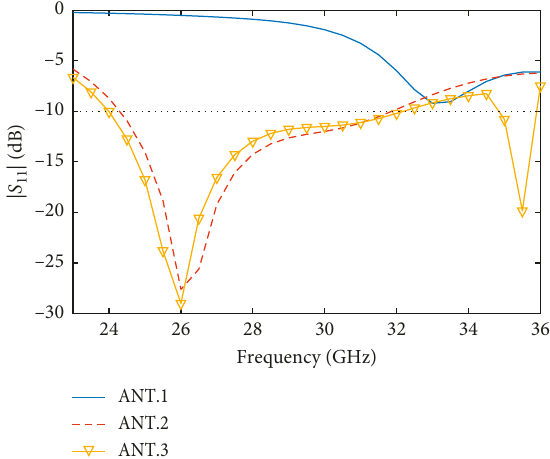
Figure 3: Simulated S